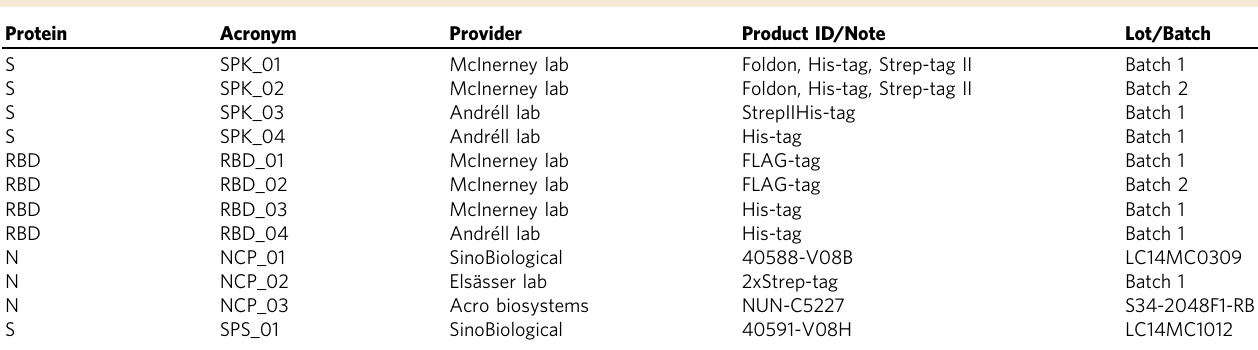
Table 1 Proteins from SARS-CoV-2.